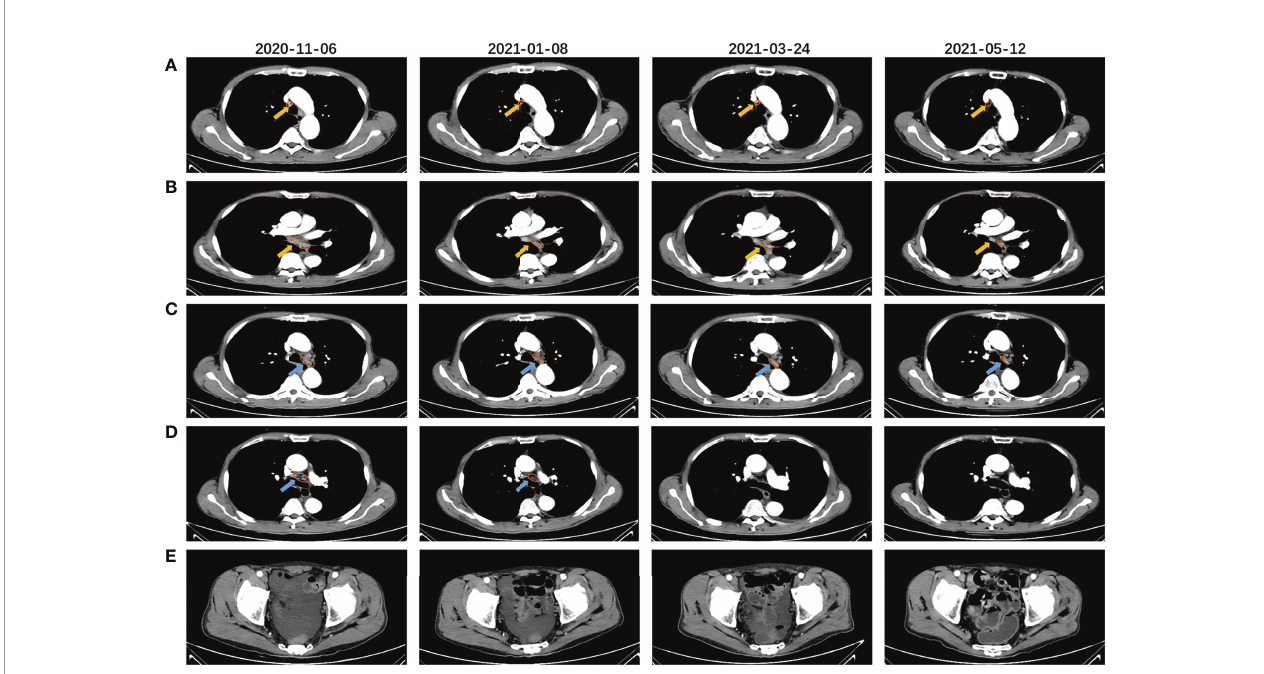
FIGURE 4 | CT scans before (2020-11.06), during (2021-01-08), and after (2121-03-24, 2021-05-12) the PRaG therapy. Right upper paratracheal (A) and subcarinal lymph node (B) were the two irradiated lesions that gradually shrunk signi fi cantly after the PRaG therapy, One of the left lower paratracheal lymph nodes (C) progressively shrunk and the other (D) rapidly shrunk and disappeared after PRaG therapy. (E) shows that pelvic effusion gradually decreased and disappeared, The yellow arrow indicated the irradiated lesions, and the blue arrow indicated the unirradiated ones; all assessed lesions were circled with orange